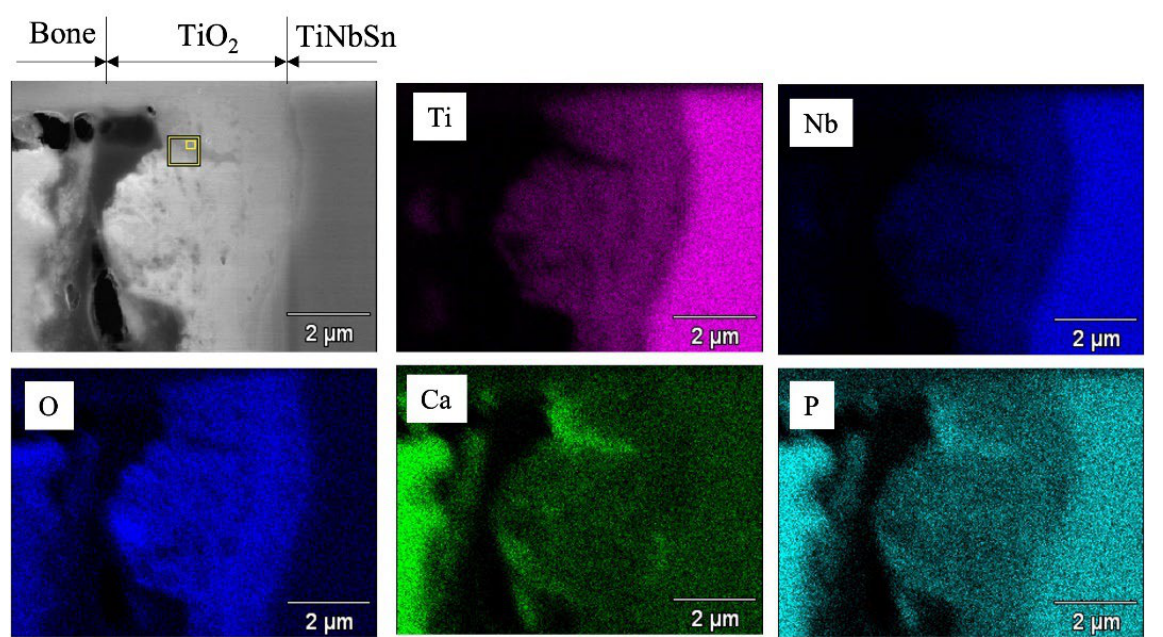
Figure 5. Evaluation of bone-metal interface by SEM image and EDX mapping of the elements with implanted TiNbSn rod . Evaluation of the bone–metal interface was performed by SEM imaging and EDX mapping of Ti, Nb, O, Ca, and P near the rabbit bone and the implanted TiNbSn rod. SEM: Scanning electron microscopy; EDX: Energy dispersive X-ray spectroscopy. (reprinted from Ref. [57] with permission).